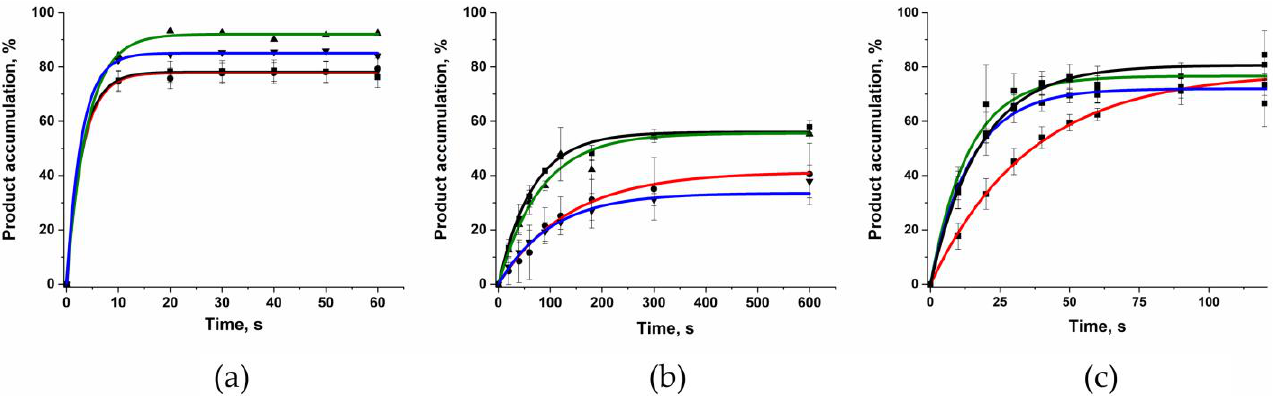
Figure 9. The dependence of the increase in the concentration of the reaction product on time. ( a ) WT Polβ, ( b ) G118V, and ( c ) R149I. The product accumulation for substrate Gap_A ( ■ ) is shown as the black curve, for Gap_T ( ● ) as the red curve, for Gap_G ( ▲ ) as the green curve, and for Gap_C ( ▼ ) as the blue curve. [DNA substrate] = 0.5 μM, [enzyme] = 0.5 μM, [dNTP] = 5 μM. Table 3. Observed rate constants k obs (s − 1 ) of gap-filling incorporation of various dNTPs into the DNA strand.